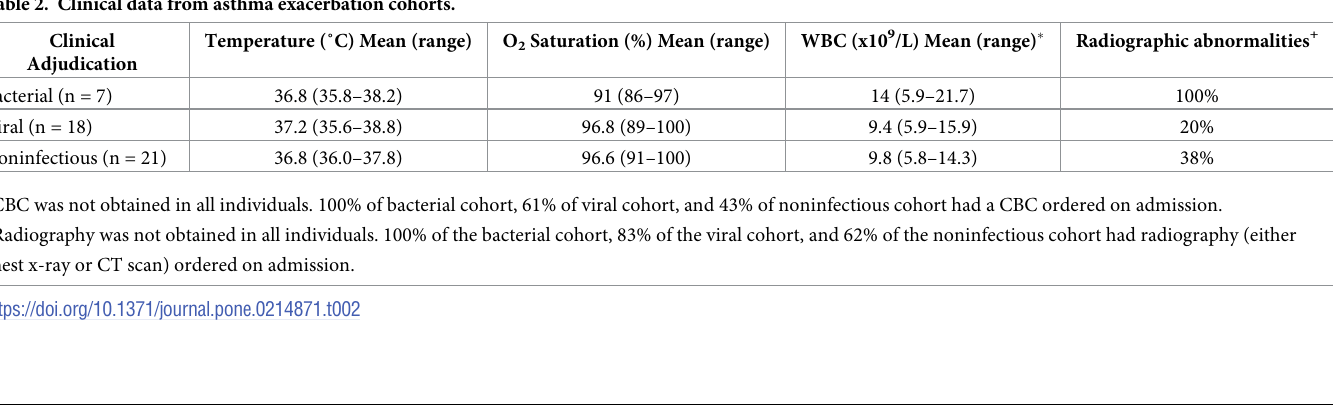
further justifying their inclusion. Ethnicity and gender were well-balanced across groups. The